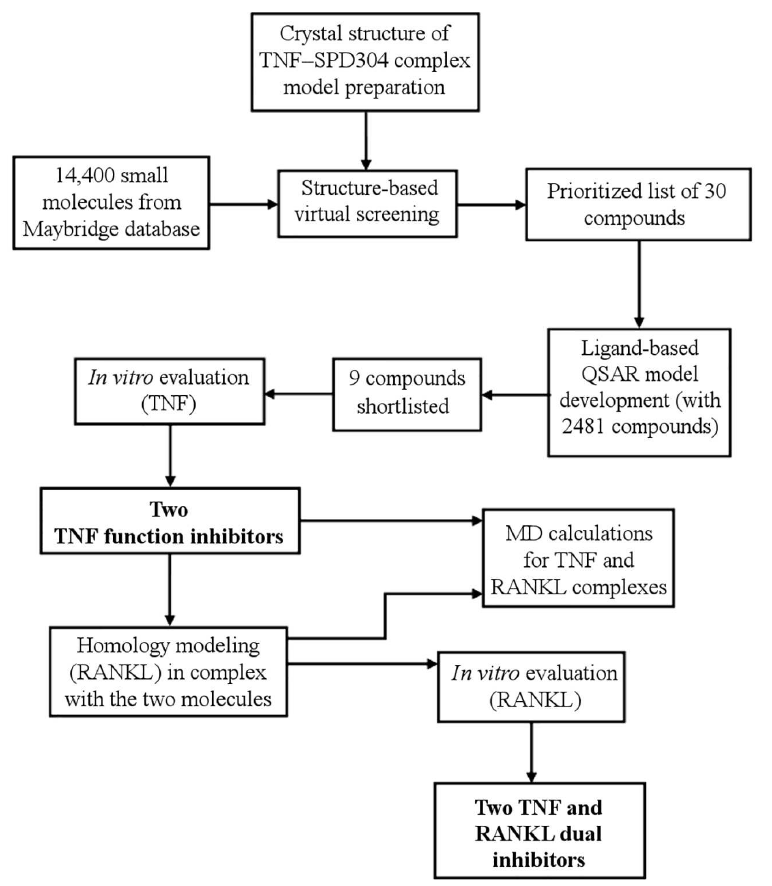
Fig 2. Strategy for the identification of new small-molecule PPI inhibitors for TNF and